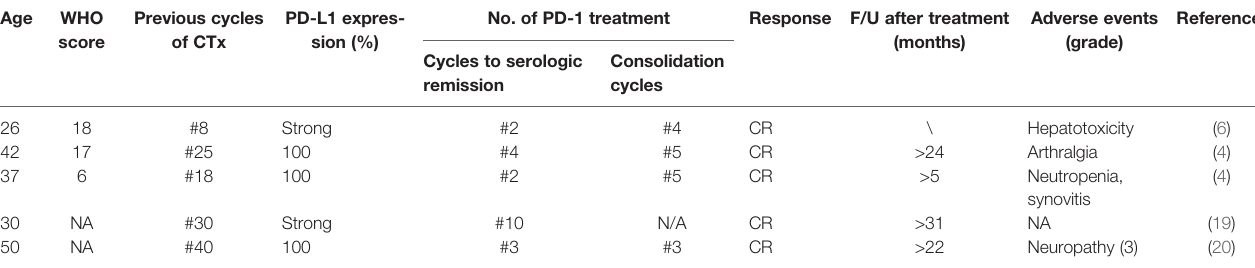
TABLE 2 | Treatment response to PD-1 inhibitor in chemo-resistant choriocarcinoma by